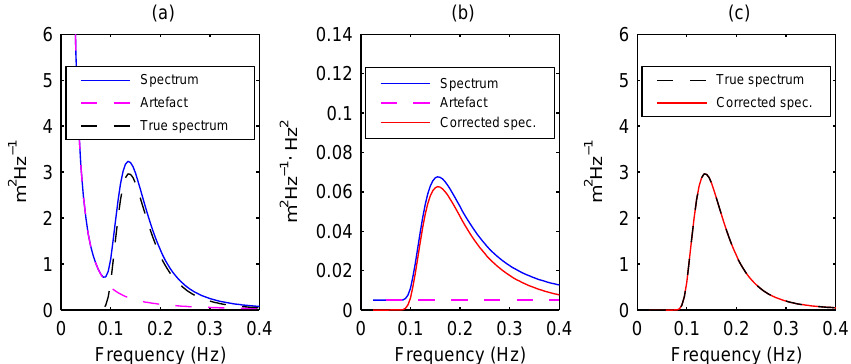
Figure 3. A schematic illustration of the approach to correct a wave spectrum with erroneous trend. A hypothetical spectrum containing erroneous low-frequency energy is shown in (a) . The method scales the spectrum by multiplication of f 2 to reveal the power law of the erroneous trend (b) . The level of the trend (dashed magenta) is determined from the low frequencies where the scaled spectrum is constant, and the trend is removed from all frequencies. The de-scaled spectrum is shown in (c) .